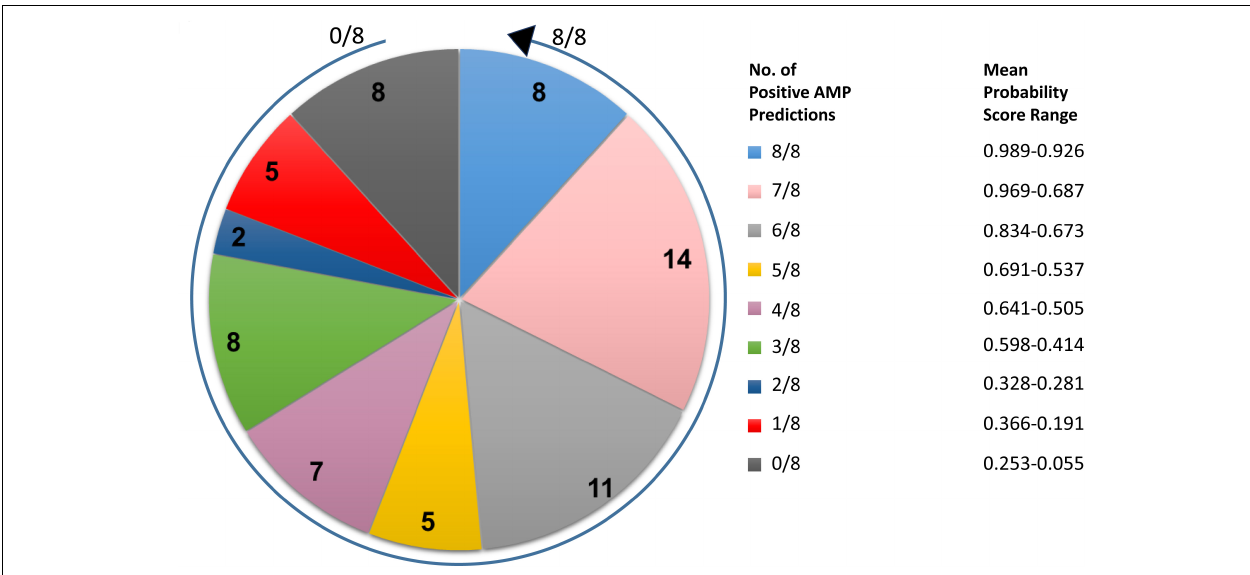
FIGURE 2 | Distribution of the number of positive AMP predictions and corresponding mean probability score ranges for T. pallidum miniproteins of unknown function. Pie chart indicating the number of positive AMP predictions following submission of the full-length amino acid sequences of 68 T. pallidum miniproteins ( ≤ 150 amino acids) to three AMP prediction servers (eight AMP prediction algorithms total). The arrow begins at the 0/8 positive AMP prediction class and finishes at the 8/8 positive AMP prediction class. The corresponding mean probability score range for all proteins from each positive AMP prediction class is also shown.